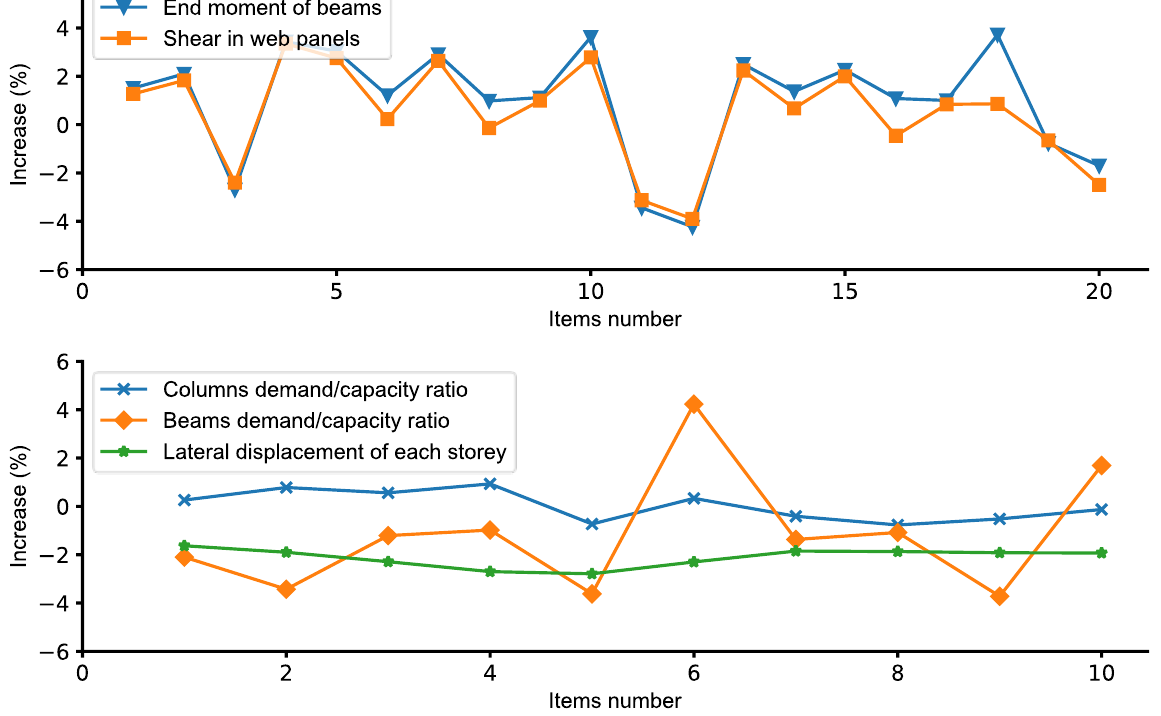
Figure 21. The relative difference for responses of the frame under the required and the obtained joints performance.